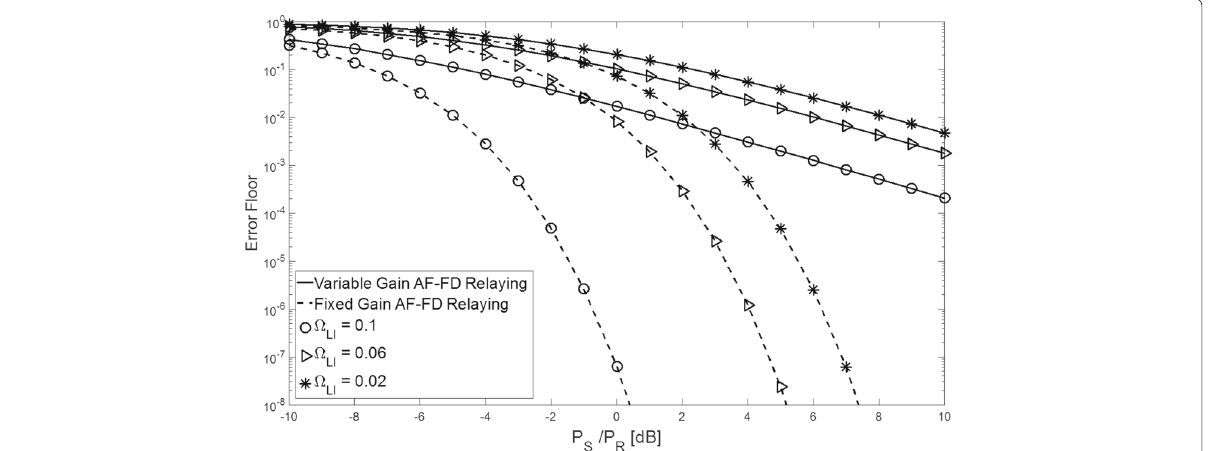
Fig. 7 Error floor of the fixed-gain and variable-gain AF-FD systems for (cid:6) SR = 1.2, (cid:6) RD = 0.8, (cid:6) LI = { 0.02,0.06,0.1 } , m SR = 2, m RD = 1.4, m LI = 1.9 and γ th =